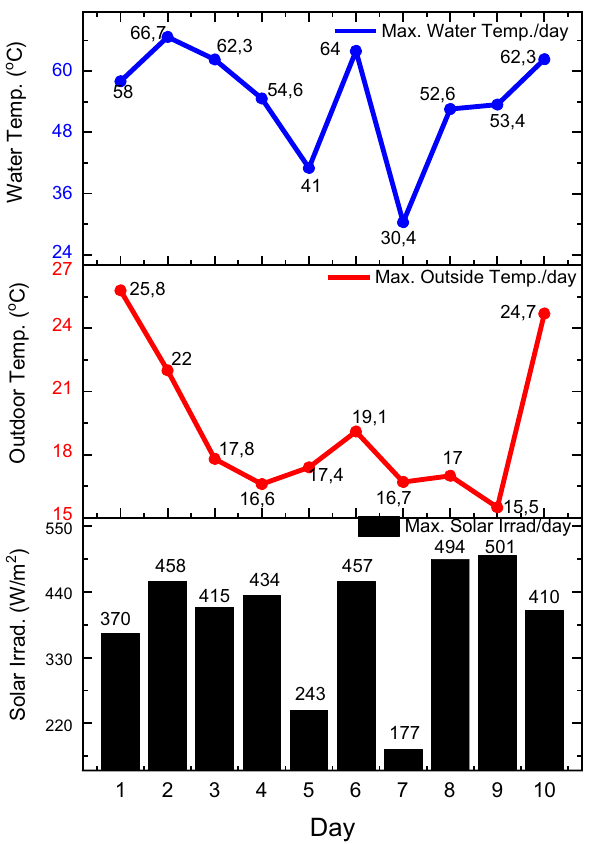
Fig. 10 Wind velocity of day 2, 6, 8 and